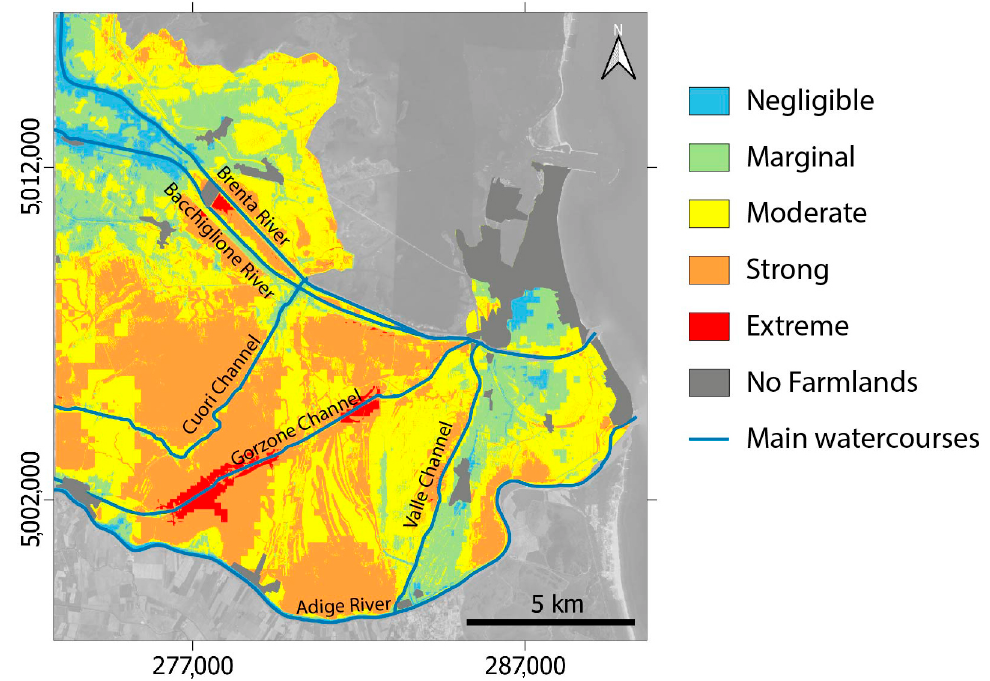
Figure 9. Map of sensitivity of farmlands to saltwater intrusion. The map was computed by accounting for the sensitivity indicators: SAD, FRD, GEL, RGLC, PER, and ROF. Coordinate system: UTM33, WGS84.